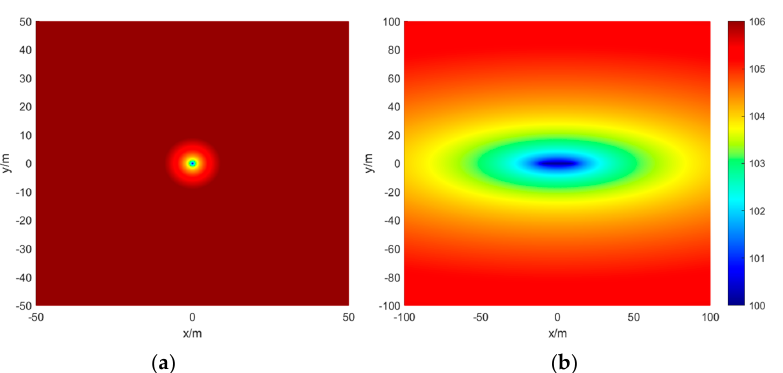
Figure 1. Pressure field distribution of a single borehole coal seam in homogeneous state: ( a ) Un- fractured coal seam, ( b ) Coal seam fracturing.